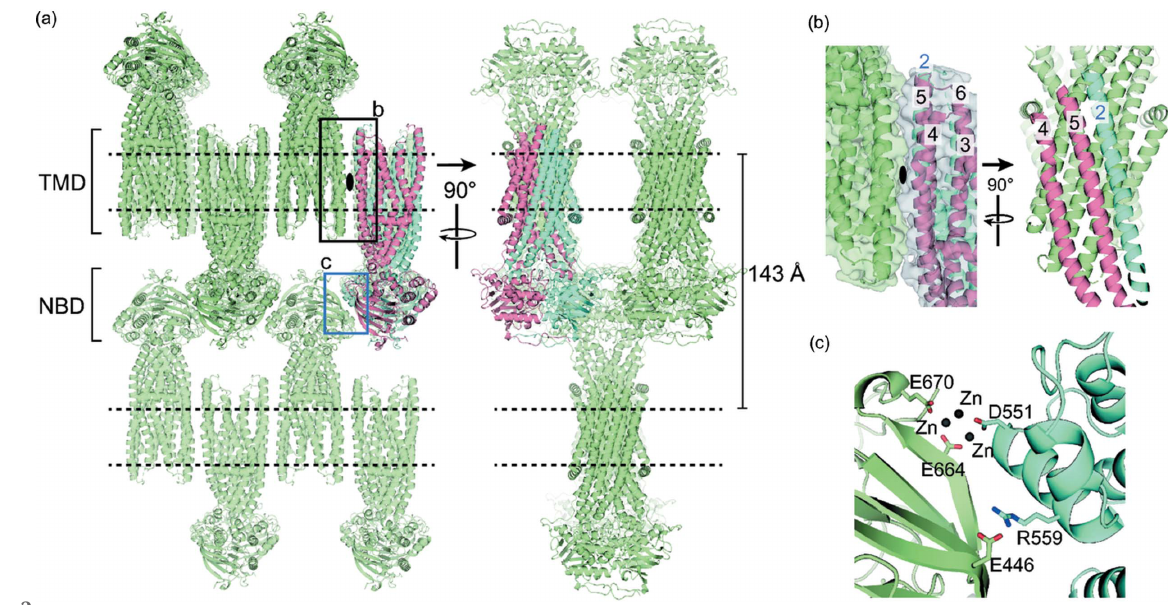
Figure 2 Type I crystal packing of the CmABCB1 QTA OF crystal structure. ( a ) Crystal packing of CmABCBC1 QTA molecules shows alternating layers of antiparallel homodimers within the crystal. ( b ) An interface formed by the TM2, TM4 and TM5 helices of two CmABCB1 QTA dimers. ( c ) Major interactions at the NBD interface.